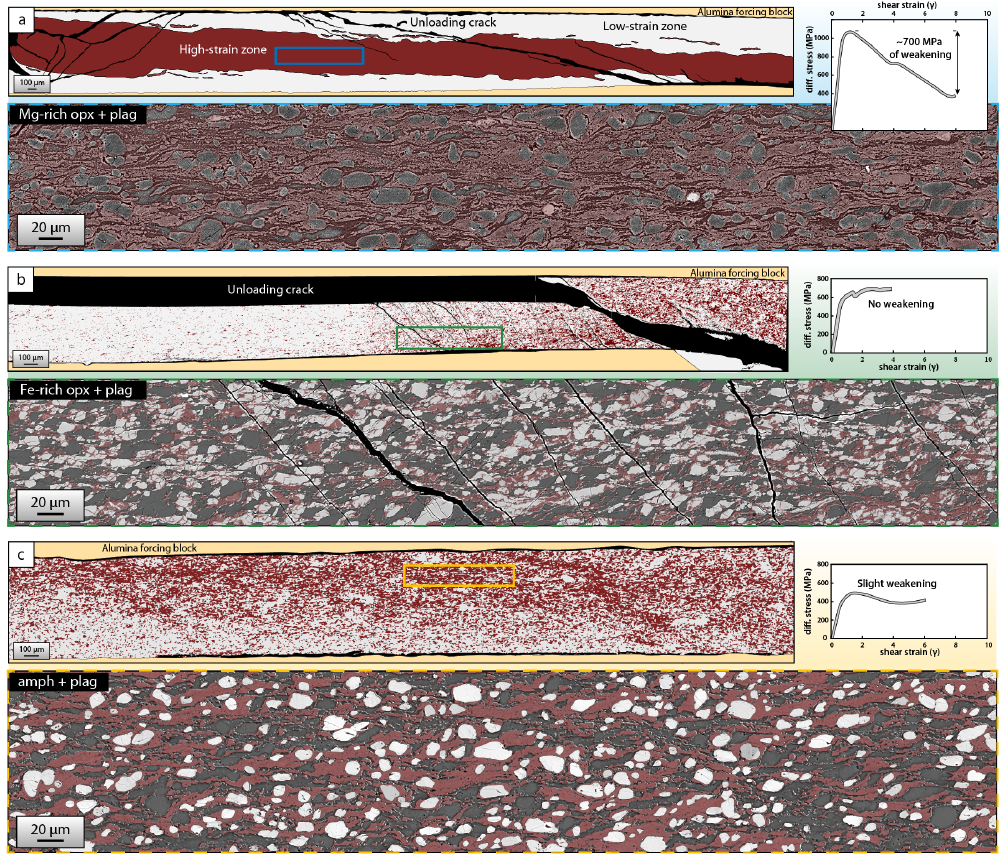
Figure 3. Distribution of reaction products after deformation in the Mg-rich opx + plag (a) , Fe-rich opx + plag (b) , and amph + plag (c) assemblages. For each assemblage, a manually digitized overview of the shear zone is associated with a zoomed part of it. The mechanical data associated with these assemblages are also represented in stress–strain